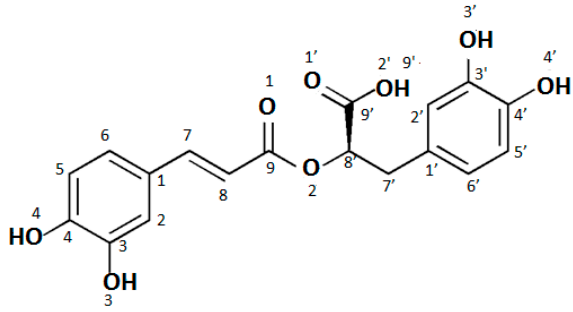
Figure 1. Numbering of atoms in rosmarinic acid molecule.